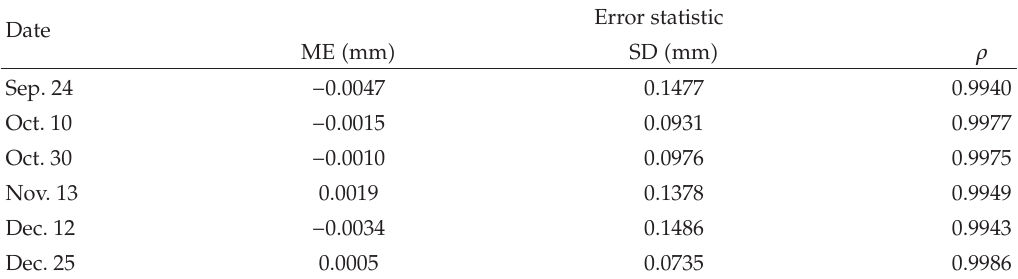
Table 2: Some error statistics from right surface predictions of all sampling points in Jiulong-Beijing track section from K612 (cid:8) 000 to K614 (cid:8)